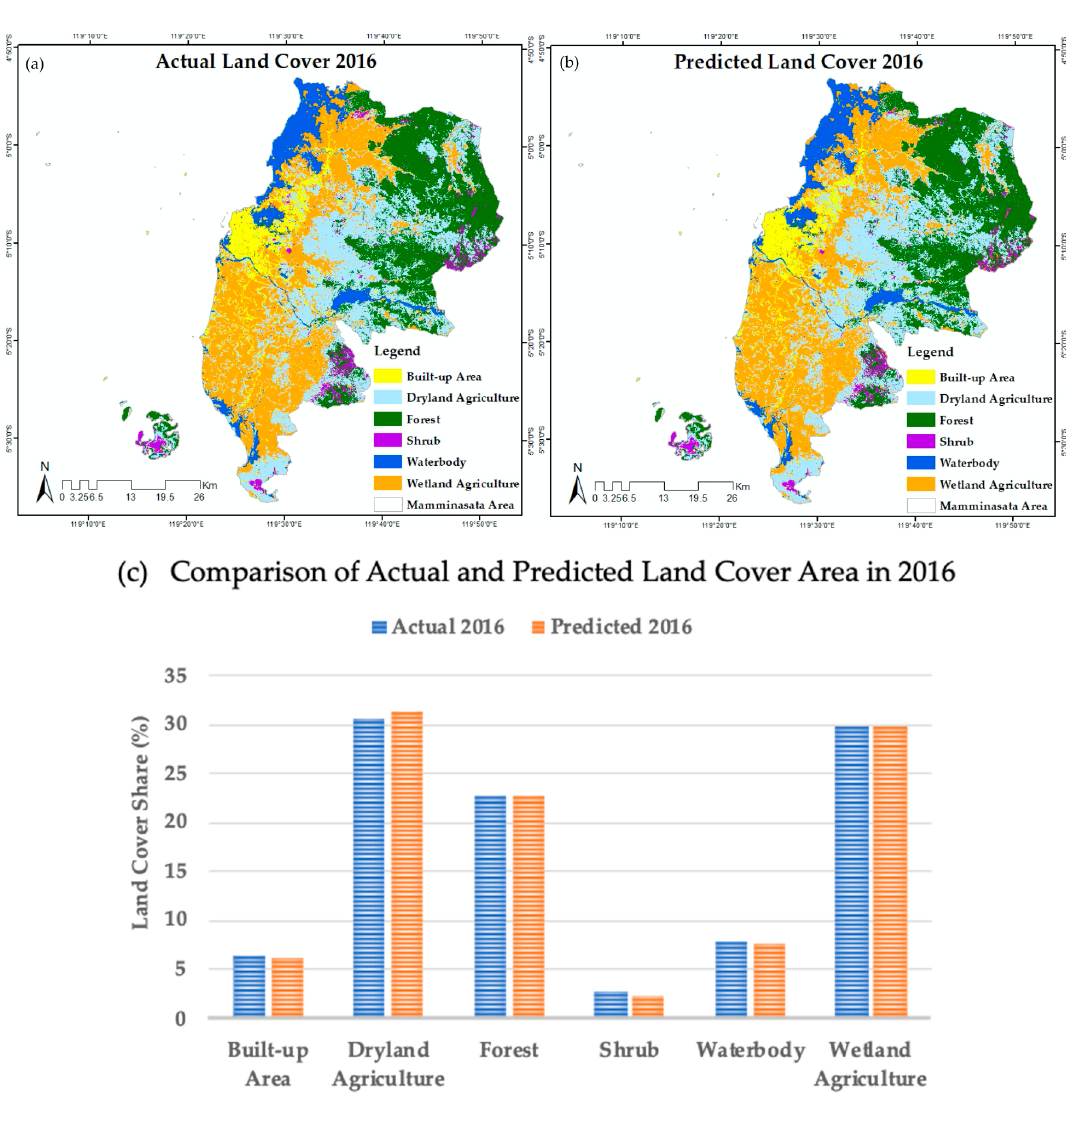
Figure 8. Actual land cover derived by satellite data ( a ); predicted land cover by multi-layer perceptron